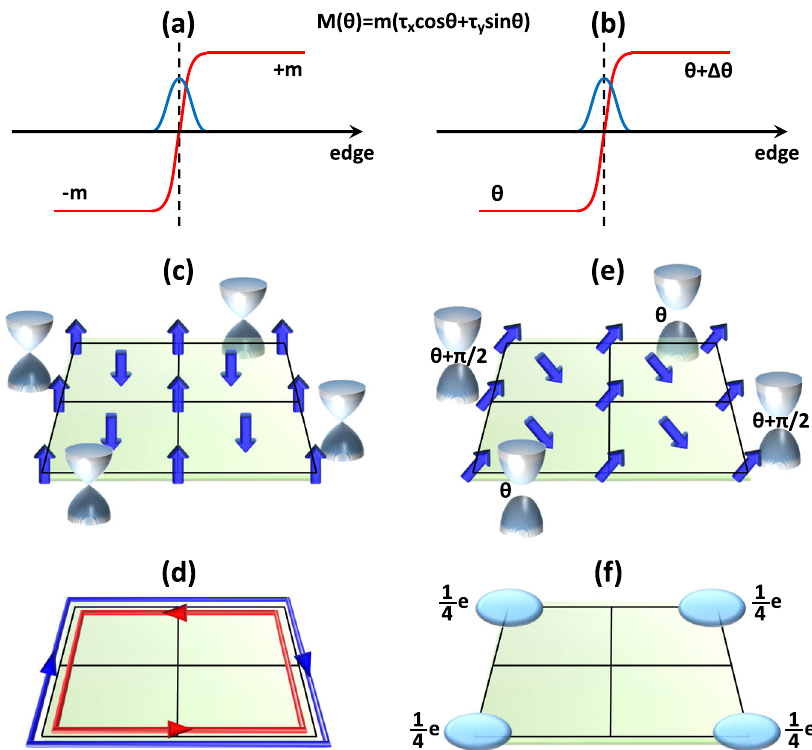
Fig. 1 Fractional mass-kink induced topological corner state with a fractional charge of e/4. Schematic mass distribution along the edge (red line) and localized domain wall state (blue line) for a mass-inversion, b fractional mass-kink. The mass M is de fi ned in edge state space, m is mass-intensity, θ is mass-angle, Δ θ is phase shift across the domain wall, τ x and τ y are Pauli matrix of the edge state. c Schematic checkerboard AFM order in monolayer FeSe cluster and the gapless topological edge states. d Schematic real-space distribution of gapless topological edge state (QSH edge state), showing the propagating direction (arrow) and spin (red and blue color). e Schematic canted checkerboard AFM order in monolayer FeSe cluster and the gapped topological edge states. Each corner is connected by two ferromagnetic edges with the same spin. The adjacent edges have a different mass-angle of θ and θ + π / 2. f Schematic real-space distribution of in-gap topological corner state, holding a fractional charge of e/4.